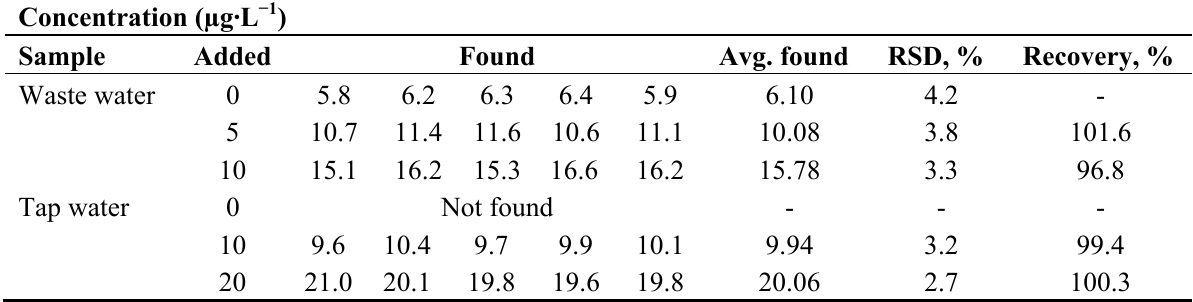
Table 2. Results obtained in analysis of waste and tap water samples with the QCM-based